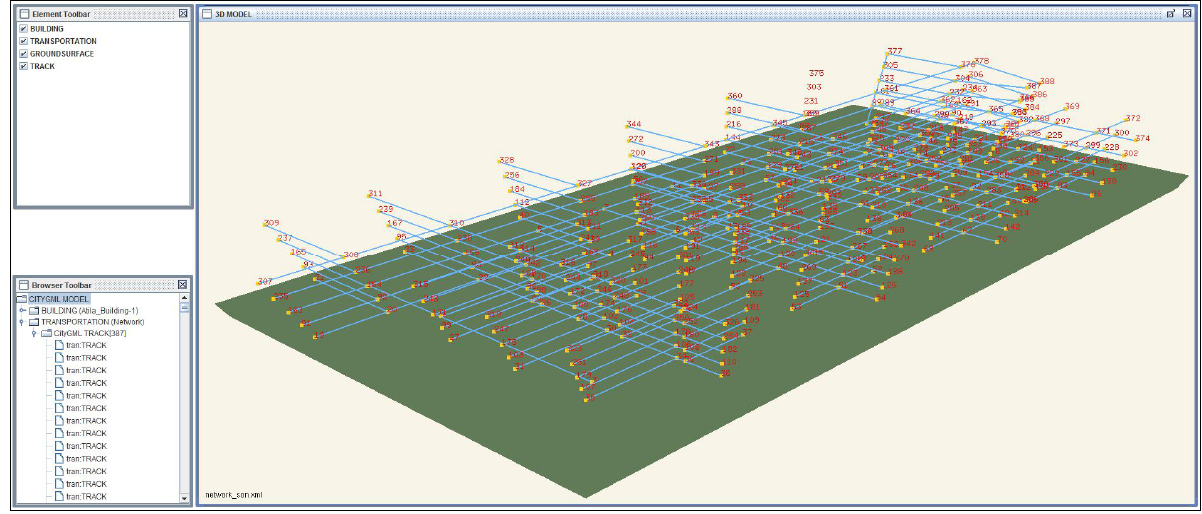
Figure 12: Visualization of Network Model from CityGML